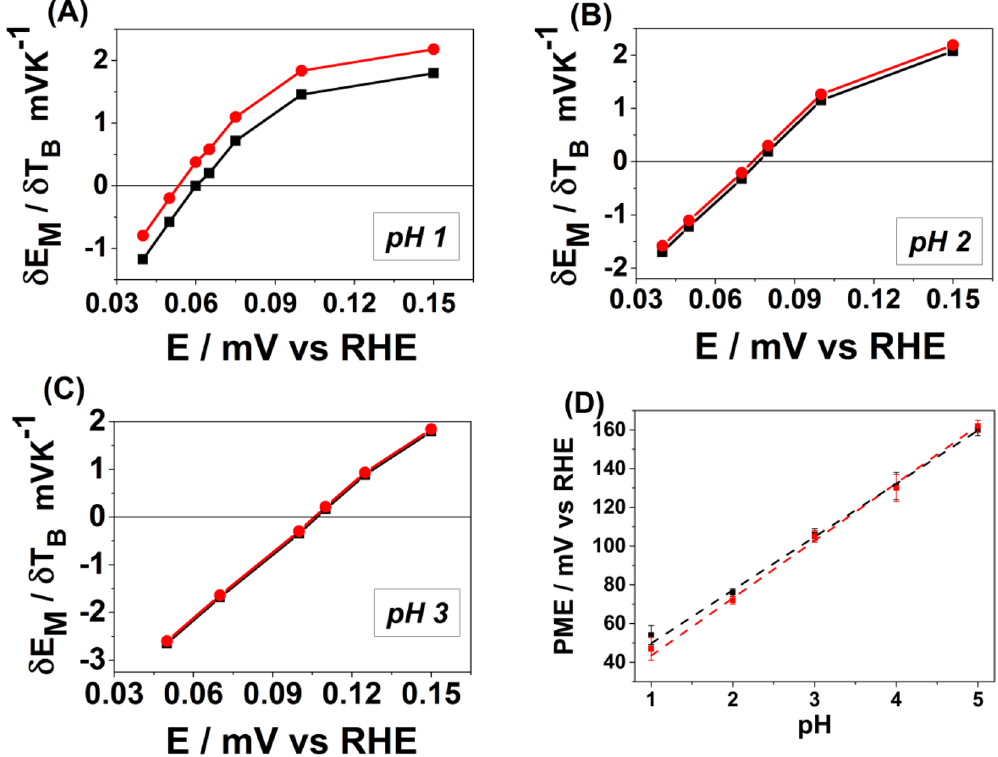
Figure 6. Temperature coefficient of the double layer potential with (red circles) and without (black squares) the thermodiffusion correction for Ir(111) at pH = 1 ( A ), pH = 2 ( B ) and pH = 3 ( C ) respectively. ( D ) Plot showing the PME values calculated at different pHs with (red symbols) and without (black) the thermodiffusion correction.